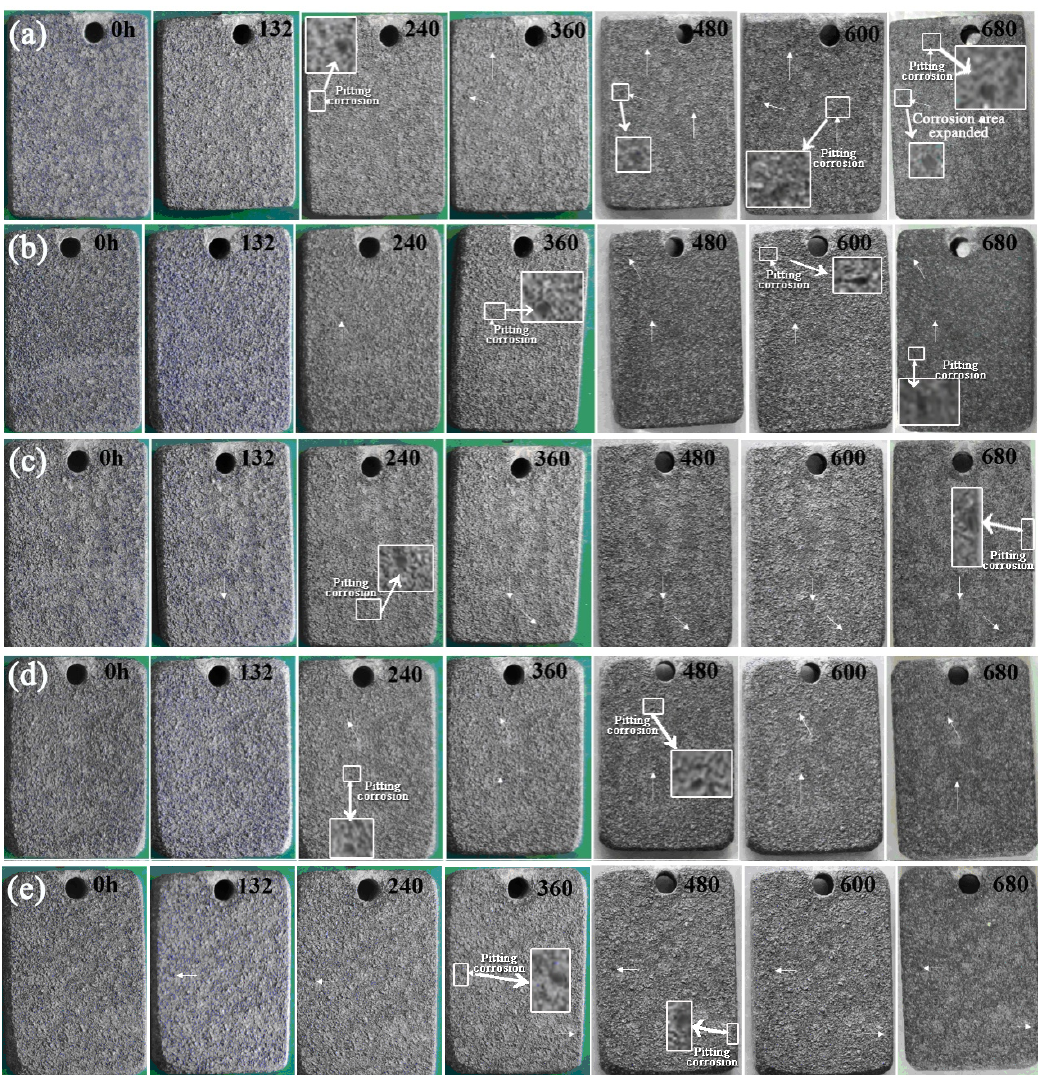
Figure 10. MAO coating after different time by salt spray corrosion. ( a ) S0; ( b ) S1; ( c ) S2; ( d ) S3; ( e ) S4.